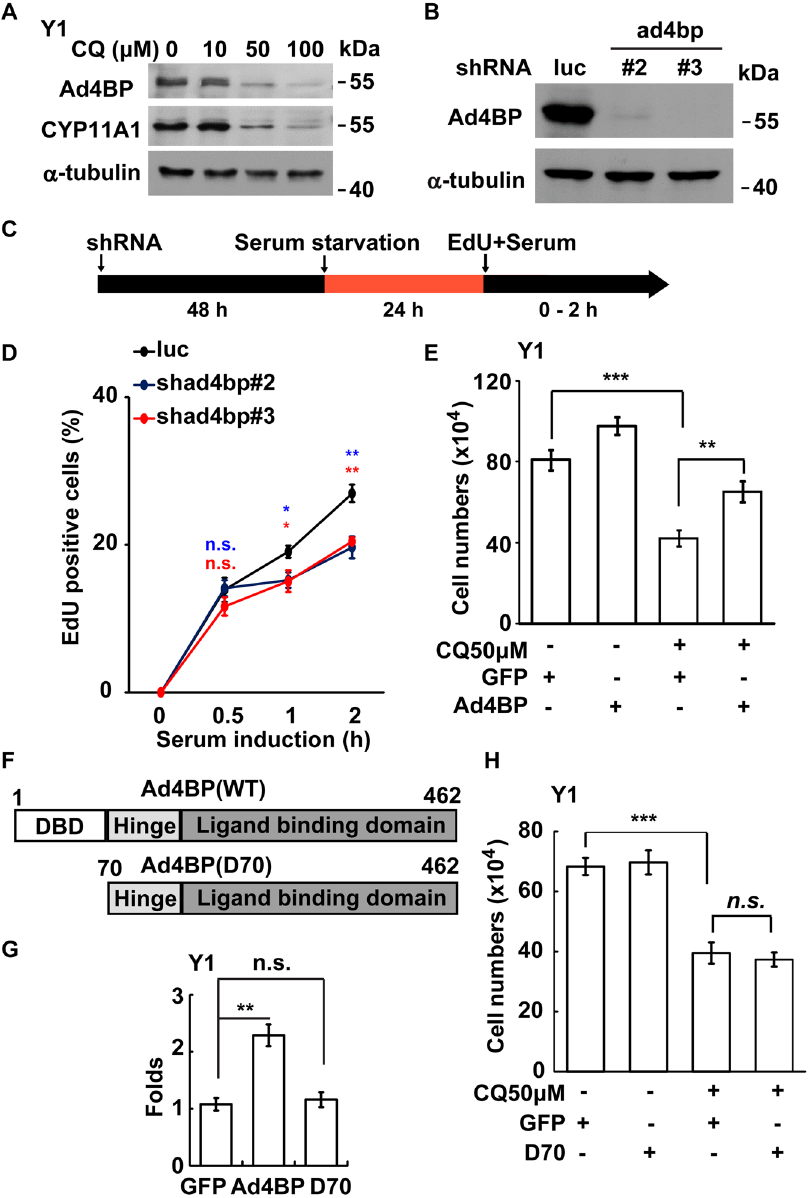
Figure 4. Lysosomal activity maintains the abundance of Ad4BP/SF-1 for steroidogenic cell growth. ( A ) Inhibition of lysosomes reduces the level of Ad4BP/SF-1. Whole cell extracts of CQ-treated TM3 cells at the concentration of 10, 50, or 100 μ M ware analyzed by immunoblot with antibodies against Ad4BP/SF-1(Ad4BP), CYP11A1 or actin. ( B – D ) Depletion of Ad4BP/SF-1 prevents S phase entry. ( B ) Ad4BP/SF-1 is depleted by shRNA efficiently. Whole cell extracts of lentivirus containing shRNA against Ad4BP/SF-1 (#2 and #3)-infected Y1 cells are analyzed by immunoblot with antibodies against Ad4BP/SF-1 and α -tubulin. ( C ) The diagram of experimental procedure. Cells were infected with lentivirus and incubated for two days followed by 24 h serum starvation. Before harvesting, the culture medium was added with serum and EdU. ( D ) Percentage of EdU- incorporating cells after infection with control shRNA (shluc) or shRNA against Ad4BP (shad4bp#2 and #3). Values are calculated as the percentages of cells positive for EdU, whose total number within each experiment was assumed to be 100%. ( E ) Overexpression of Ad4BP/SF-1 rescues CQ-induced growth delay. Quantitation of GFP or Ad4BP/SF-1 overexpressed Y1 cell numbers in the presence or absence of CQ (50 μ M). ( F , H ) Transcriptional activity is required for cell growth in CQ-treated Y1 cells. ( F ) Schematic representation of the experimental construct of wild-type (WT) or DNA-binding domain-deleted (D70) Ad4BP/SF-1. DBD: DNA- binding domain; Hinge: hinge domain. ( G ) The Luciferase activity of Ad4BP/SF-1 dependent reporter phscc - 2 . 3K - Luc were determined after co-transfection with expression plasmid of GFP, wild-type (WT) Ad4BP/SF-1, or DNA-binding deficient (D70) Ad4BP/SF-1 in Y1 cells. ( H ) Overexpression of DNA-binding deficient Ad4BP/ SF-1 dose not rescue cell growth in CQ-treated Y1 cells. Quantitation of GFP or D70 overexpressed Y1 cell numbers in the presence or absence of CQ (50 μ M). n.s.: no significance; * P < 0.05; ** P < 0.01; *** P <